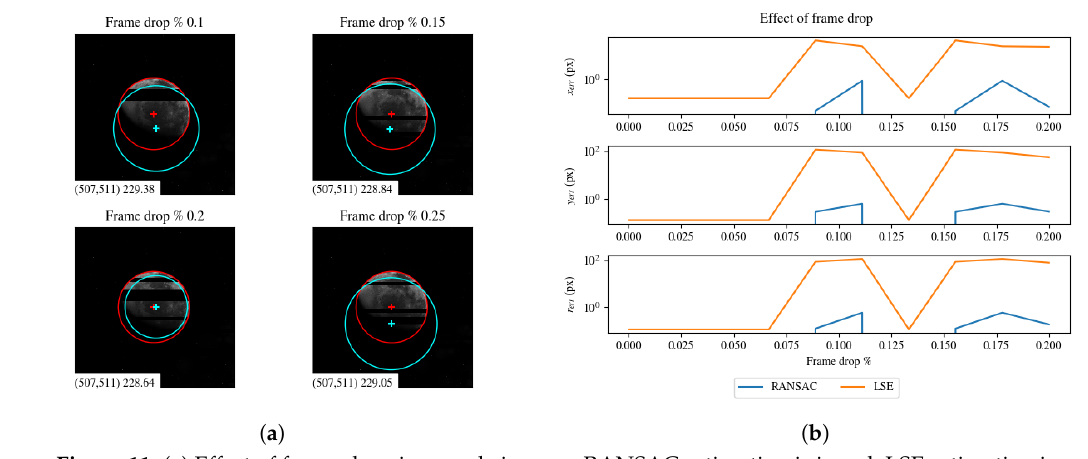
Figure 11. ( a ) Effect of frame drop in sample images. RANSAC estimation is in red, LSE estimation is in cyan. ( b ) Estimation error for an increasing percentage of frame drop. It can be noted the robustness of RANSAC with respect to LSE.